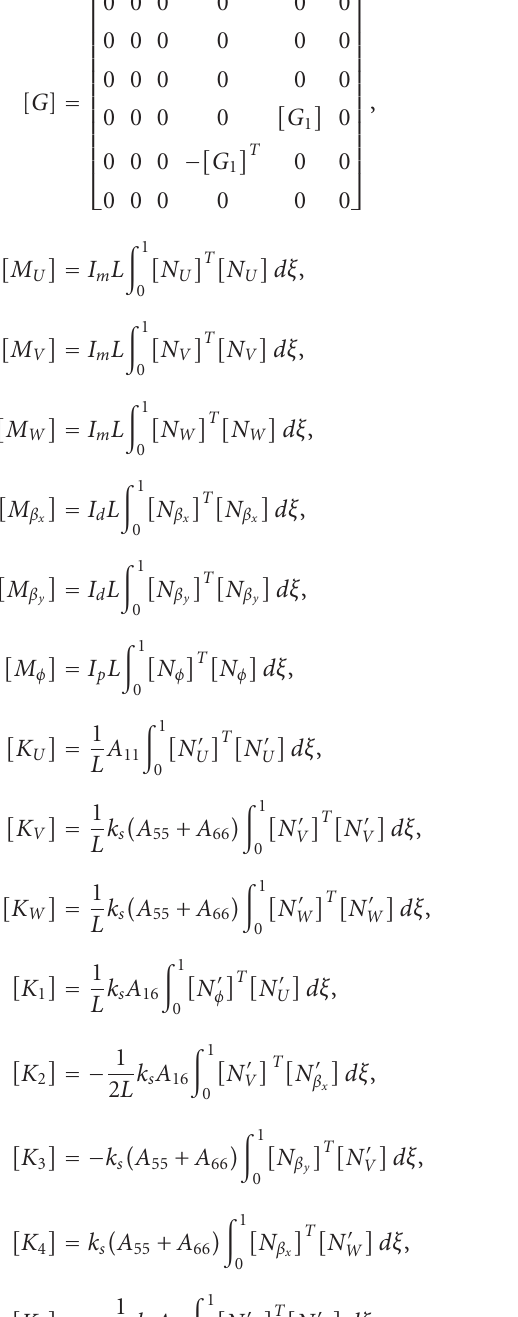
Poisson coe ffi cient Shear correction factor Mean radius of the shaft Wall thickness of the shaft The n th layer inner radius of the composite shaft The n th layer outer radius of the composite